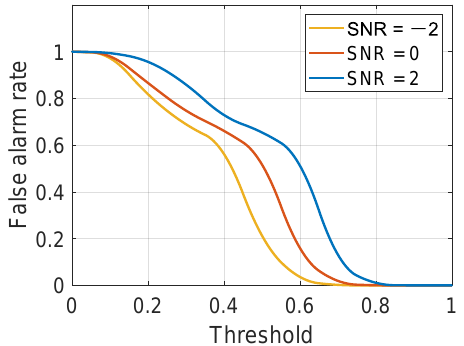
Figure 13. False alarm rate for different thresholds.